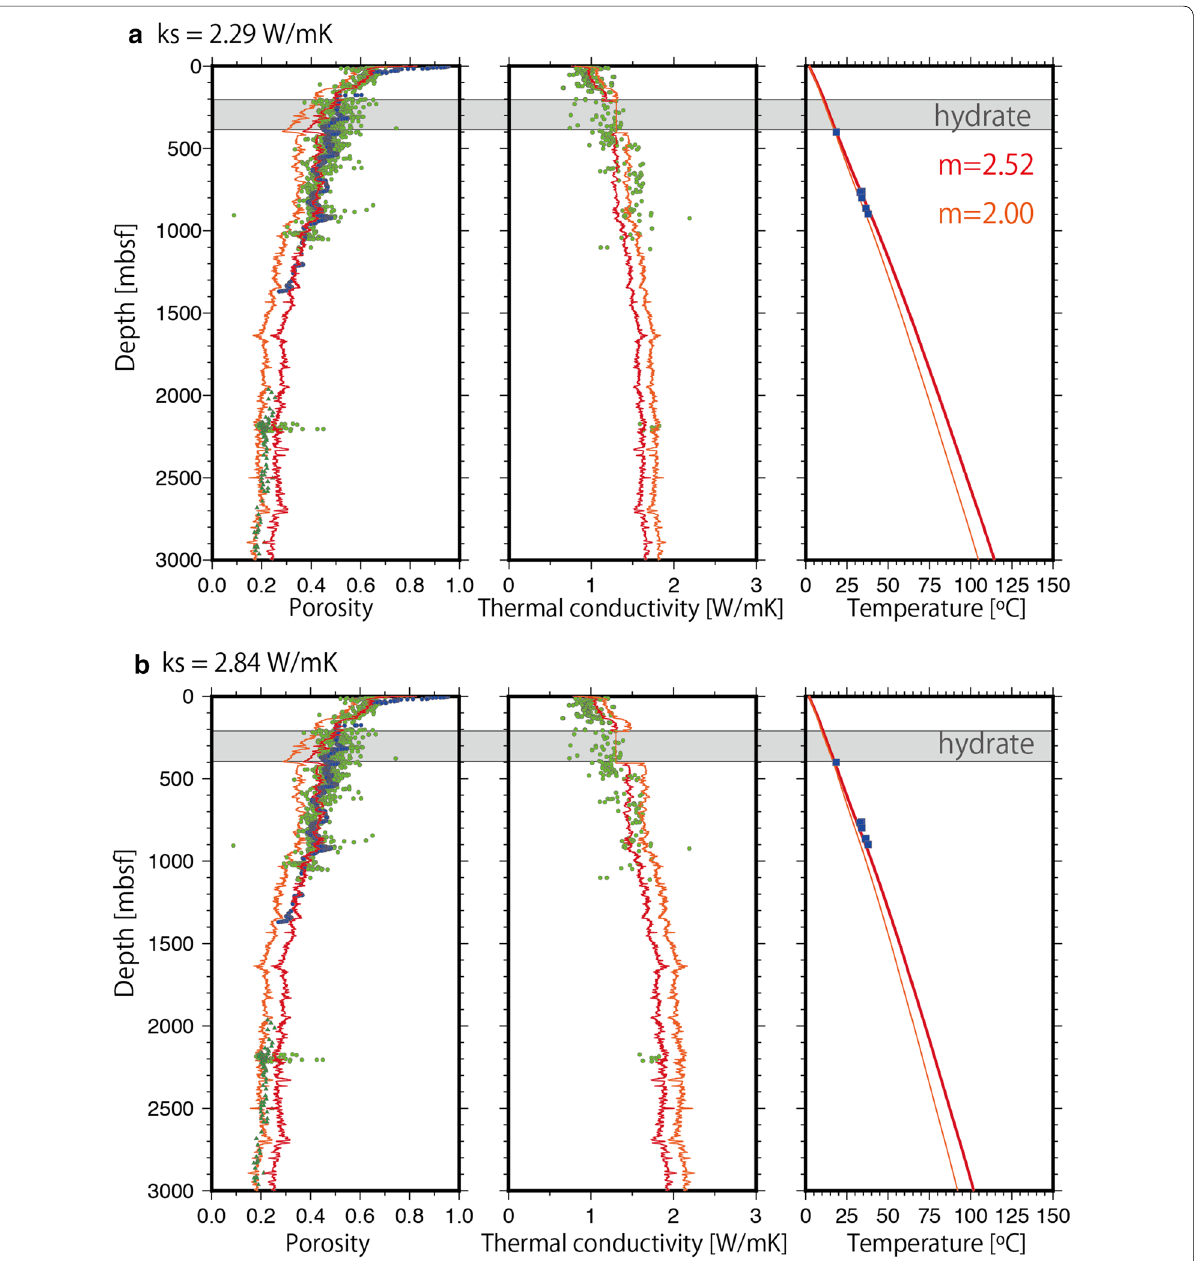
Fig. 9 Depth distributions for estimated in situ porosity, thermal conductivity, and temperature at Site C0002. a Grain thermal conductivity at 2.29 W/mK. b Grain thermal conductivity at 2.84 W/mK. The red and orange lines are values estimated with m circles are in situ porosity values calculated from density log data. The green circles are core porosity values measured onboard. The dark green triangles are the porosity values for cuttings measured onboard. Blue squares are in situ temperature measurements. Gray bands at 200–400 mbsf depth represent the hydrate